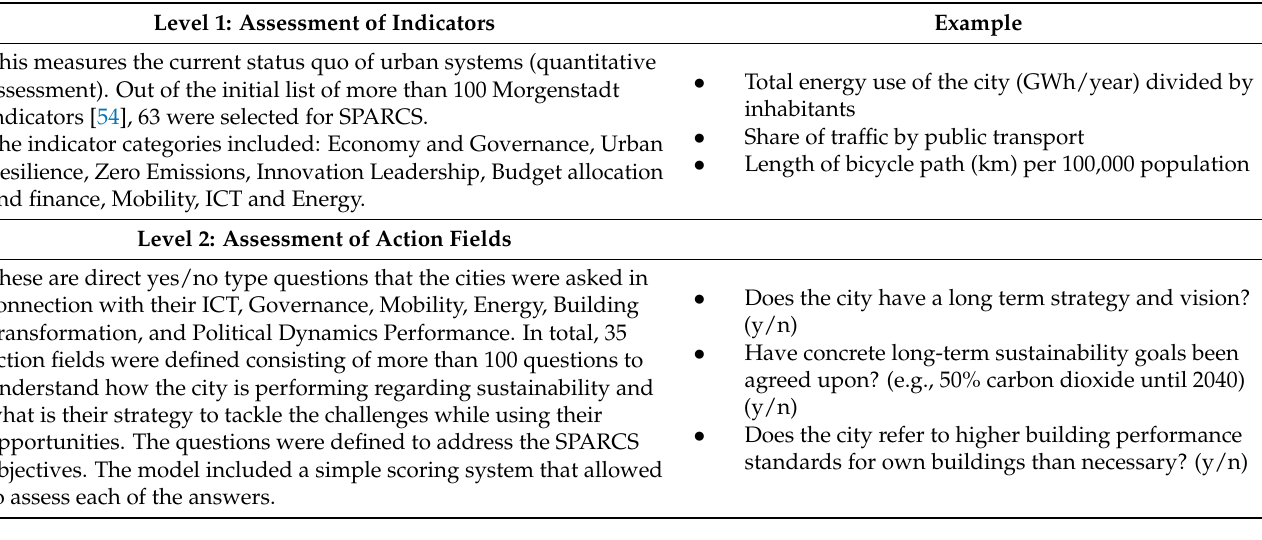
Table 2. Two analysis levels Morgenstadt